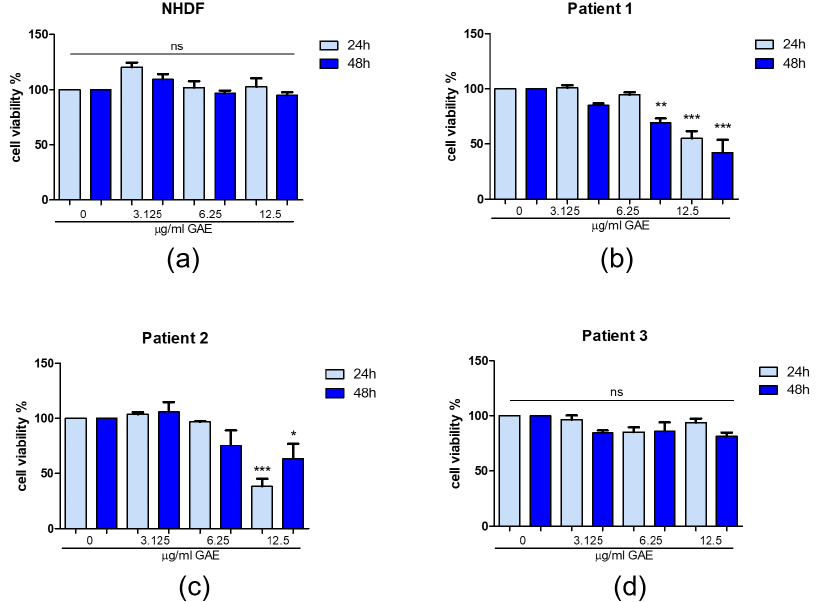
Figure 1. Cell viability after phenolic sumac extract treatment in NHDF ( a ), patient 1 ( b ), patient 2 ( c ), patient 3 ( d ). MTT assay was performed at 24 h and 48 h post-treatment. Cell viability was expressed as % of control (0 µ g/mL GAE). All data represent the means of at least 3 replicates ± standard deviation. The analysis of variance was carried out using the One-way ANOVA test followed by the Tukey’s Multiple Comparison Test; * p < 0.05, ** p < 0.01, *** p < 0.001 were considered significant (untreated control vs. treated samples). NHDF: normal human dermal fibroblast; GAE: gallic acid equivalents.